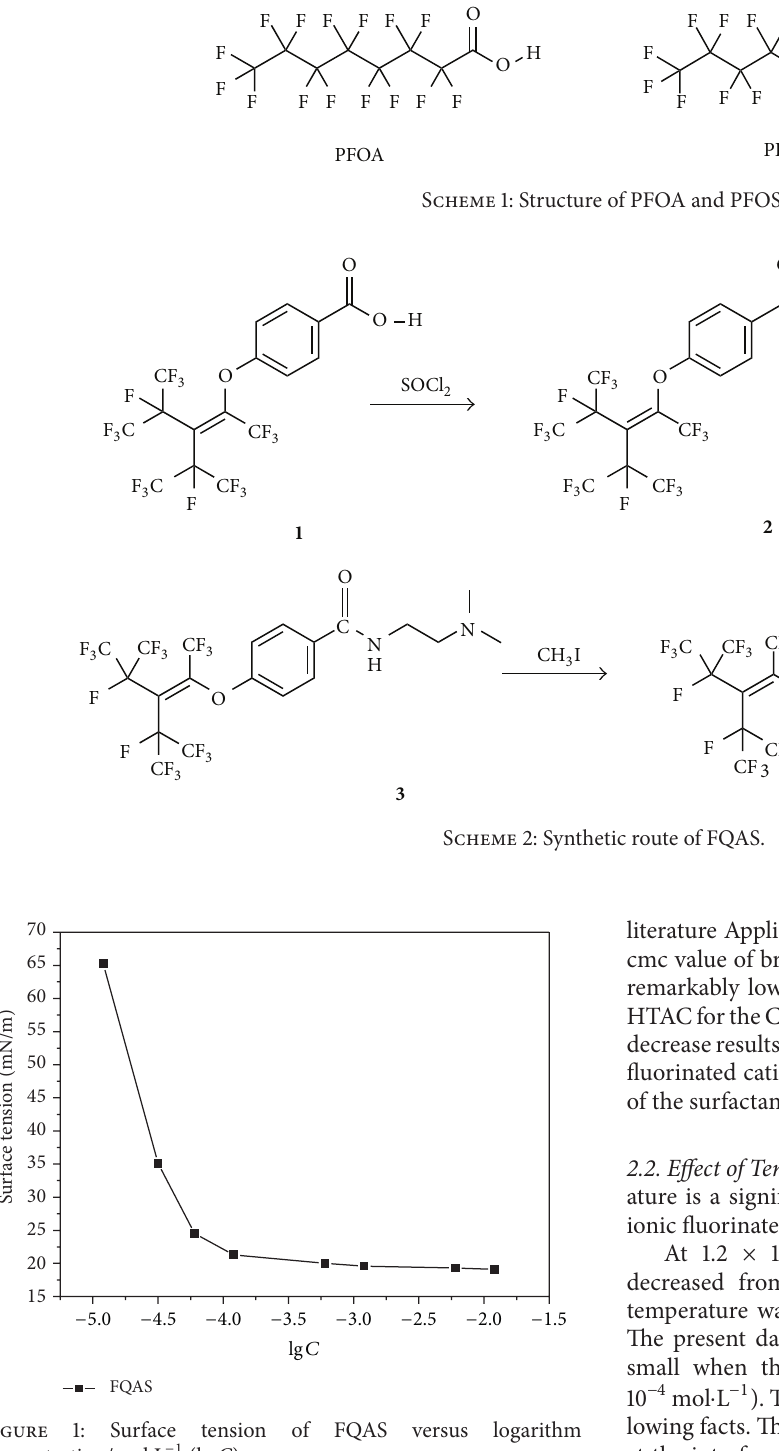
Figure 1: Surface tension of FQAS versus logarithm concentration/mol ⋅ L −1 (lg C